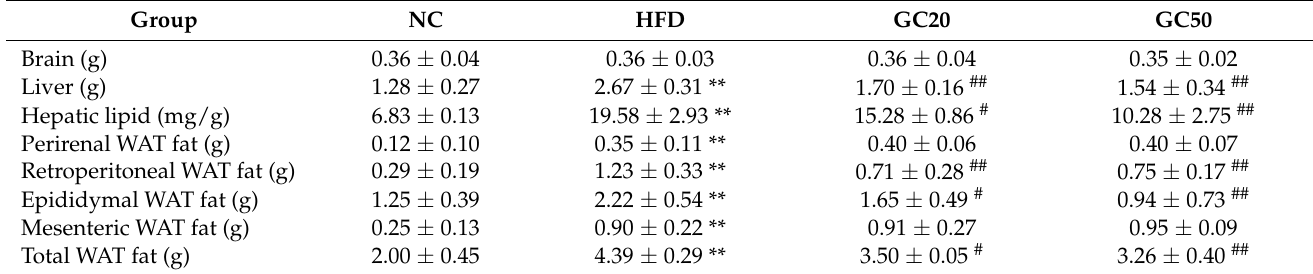
Table 4. Effect of 80% ethanolic extract from Gimcheon 1ho (GC) cultivar walnut ( Juglans regia ) on organ weights.